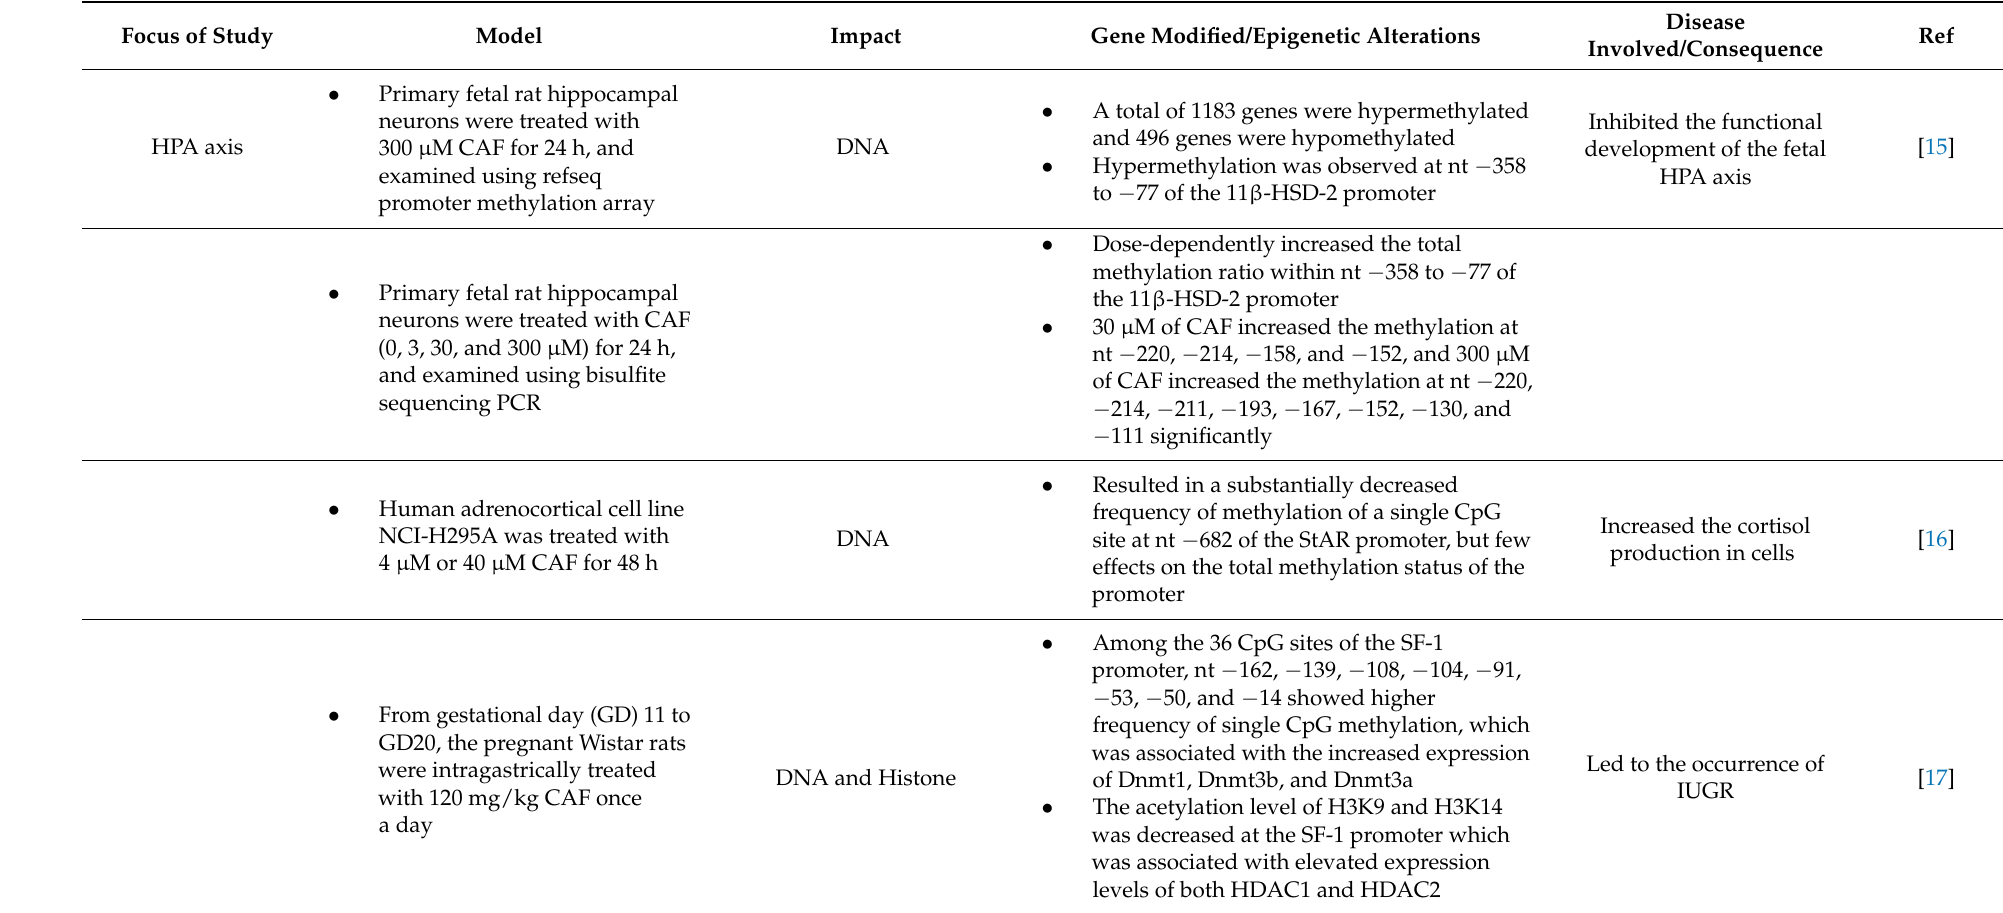
Table 2. Coffee-induced epigenetic